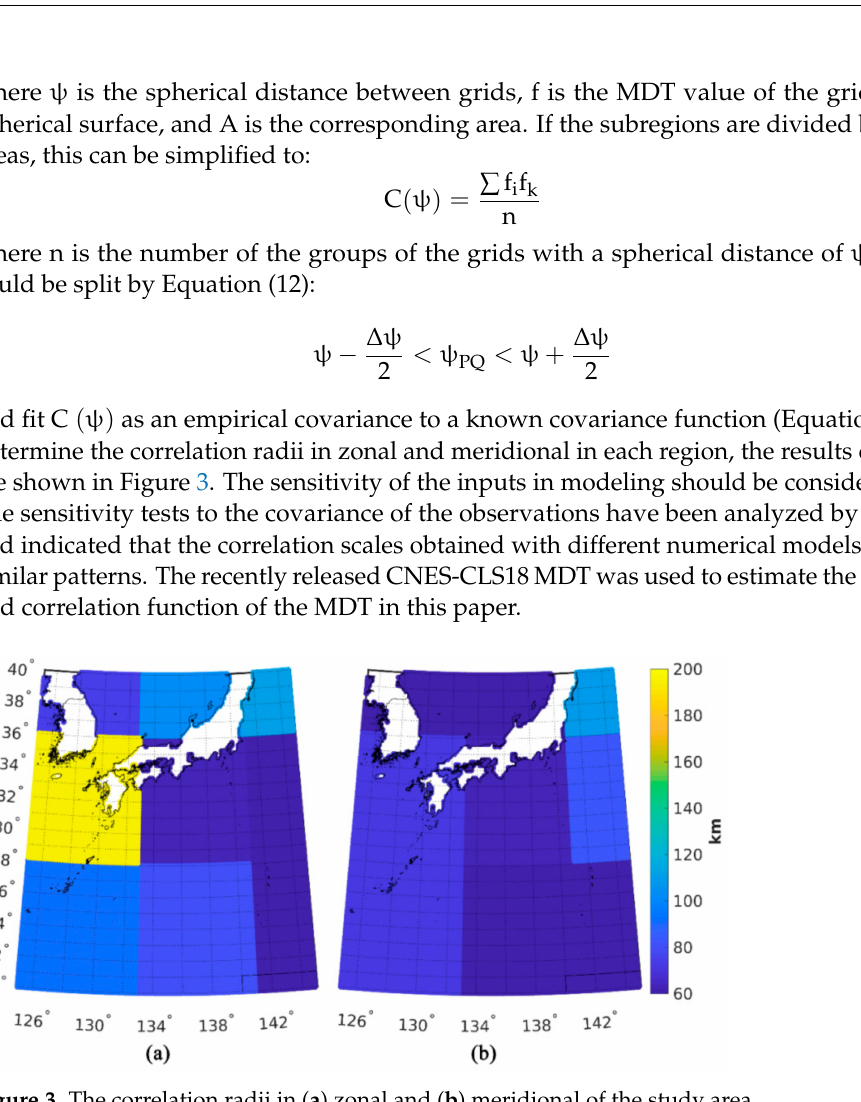
Figure 3. The correlation radii in ( a ) zonal and ( b ) meridional of the study